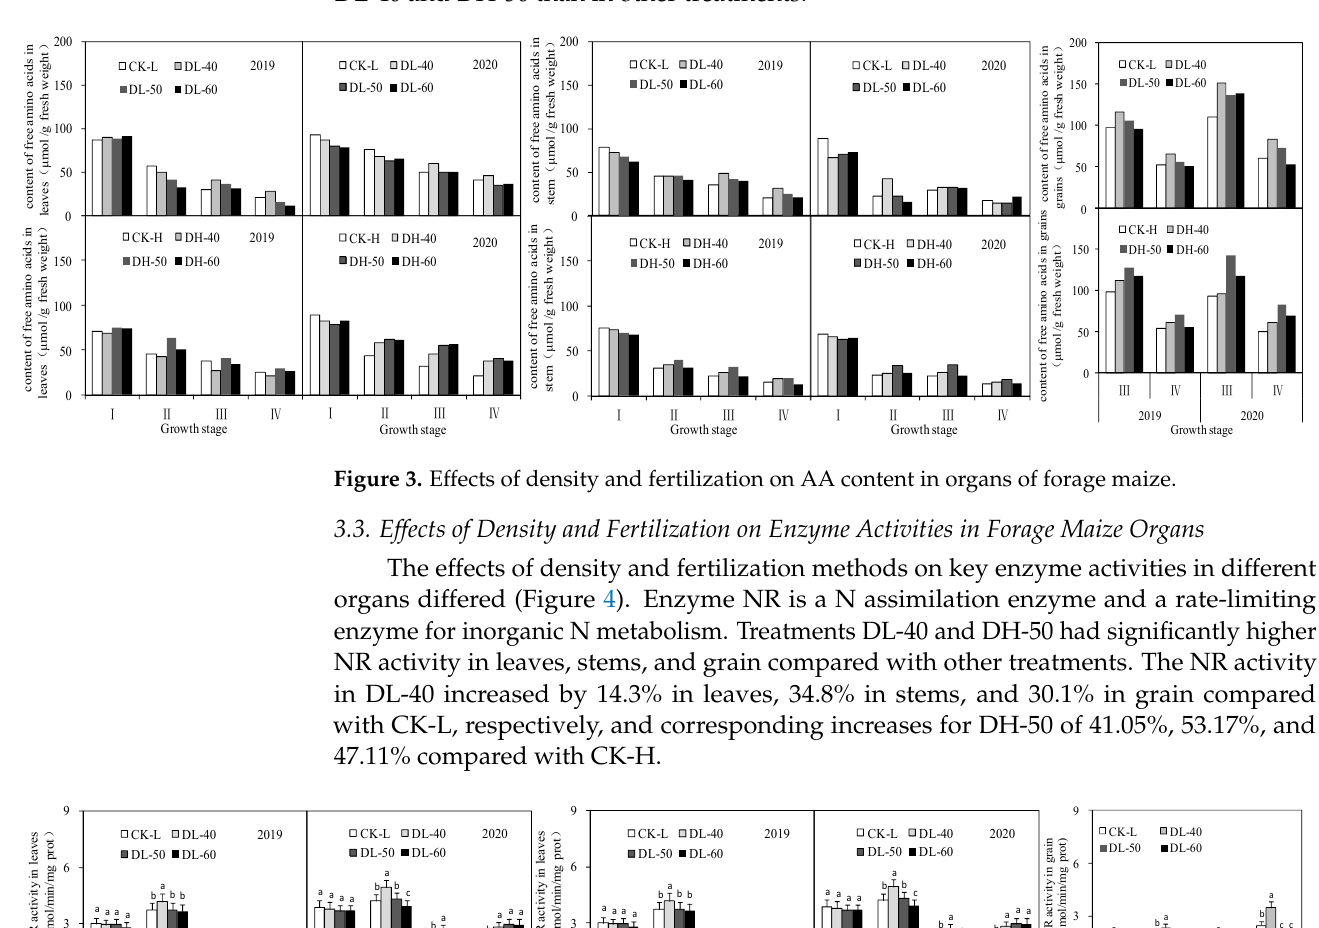
Figure 2. Effects of density and fertilization on N/K in organs of forage maize. Notes: I: jointing stage; II: tasseling stage; III: filling stage; IV: dough stage, the same notation applies to the other figures. Different letters on bars indicate significant differences among treatments at the 0.05 prob- ability level.